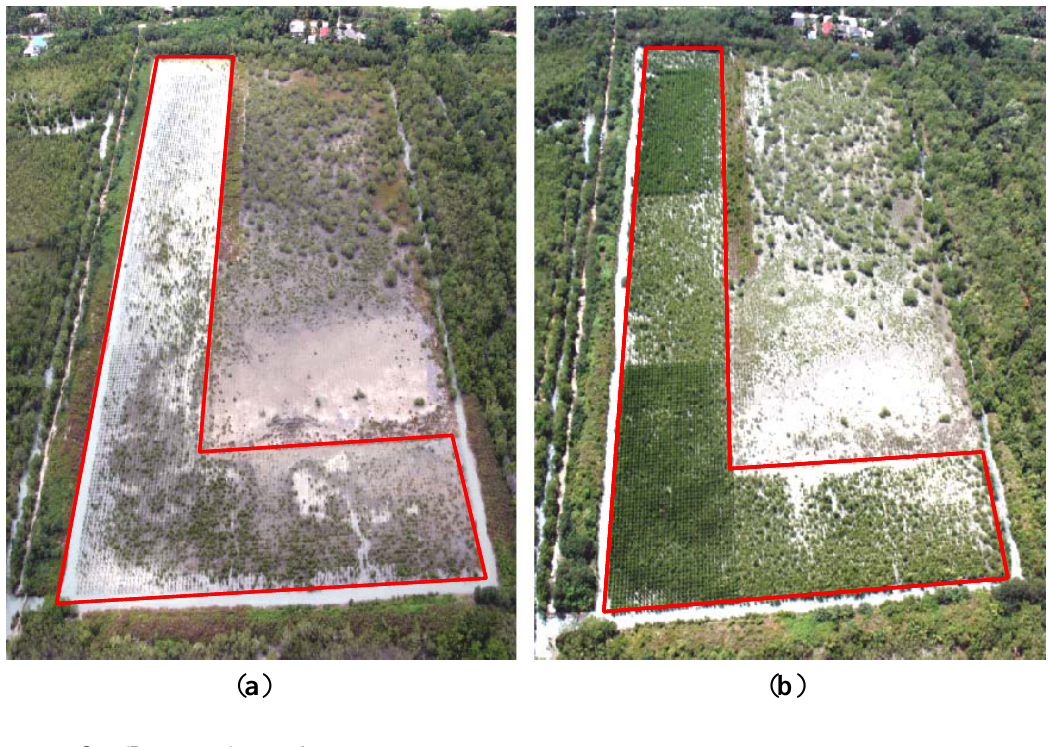
Figure 8. Aerial pictures were taken from a radio-controlled helicopter from 500 m above sea level ( a ) in September 2003 and ( b ) in February 2006. The area enclosed by the red line shows the excavated area. Comparison of the two images indicates that favorable mangrove growth was seen in the excavated area and that growth of AM was negligible in the unexcavated area despite its vigorous initial